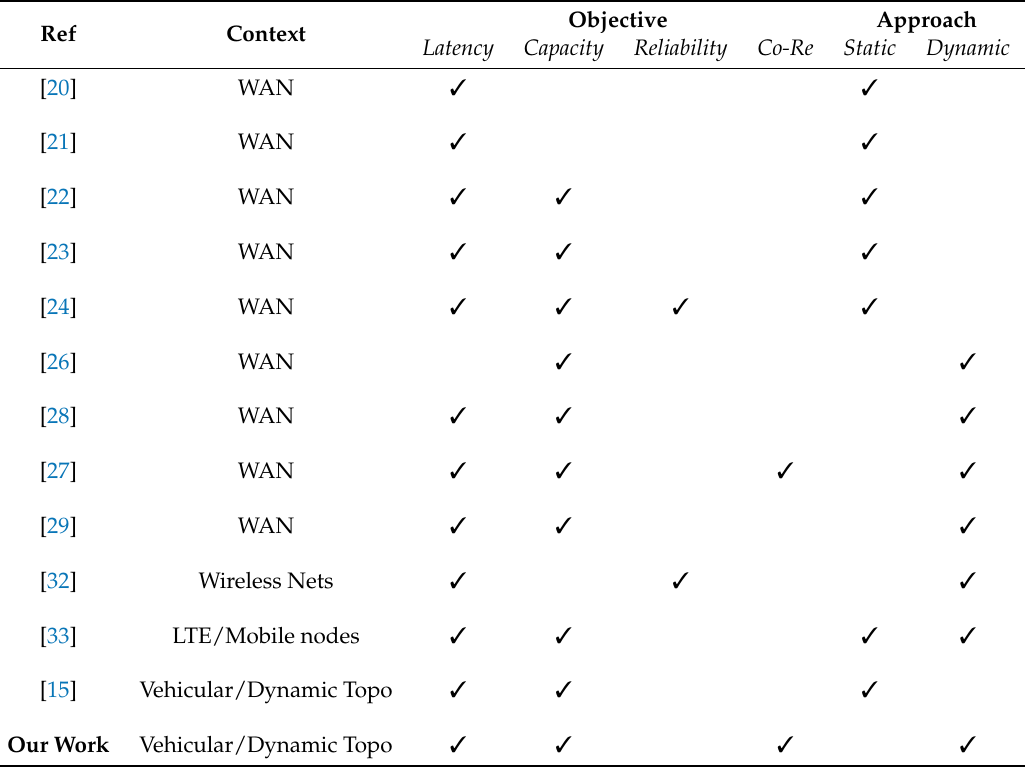
Table 1. Positioning w.r.t. related work.